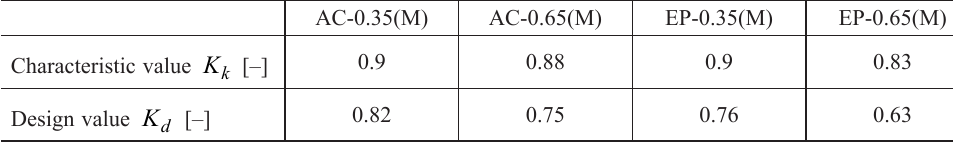
Table 2. Characteristic and design values of